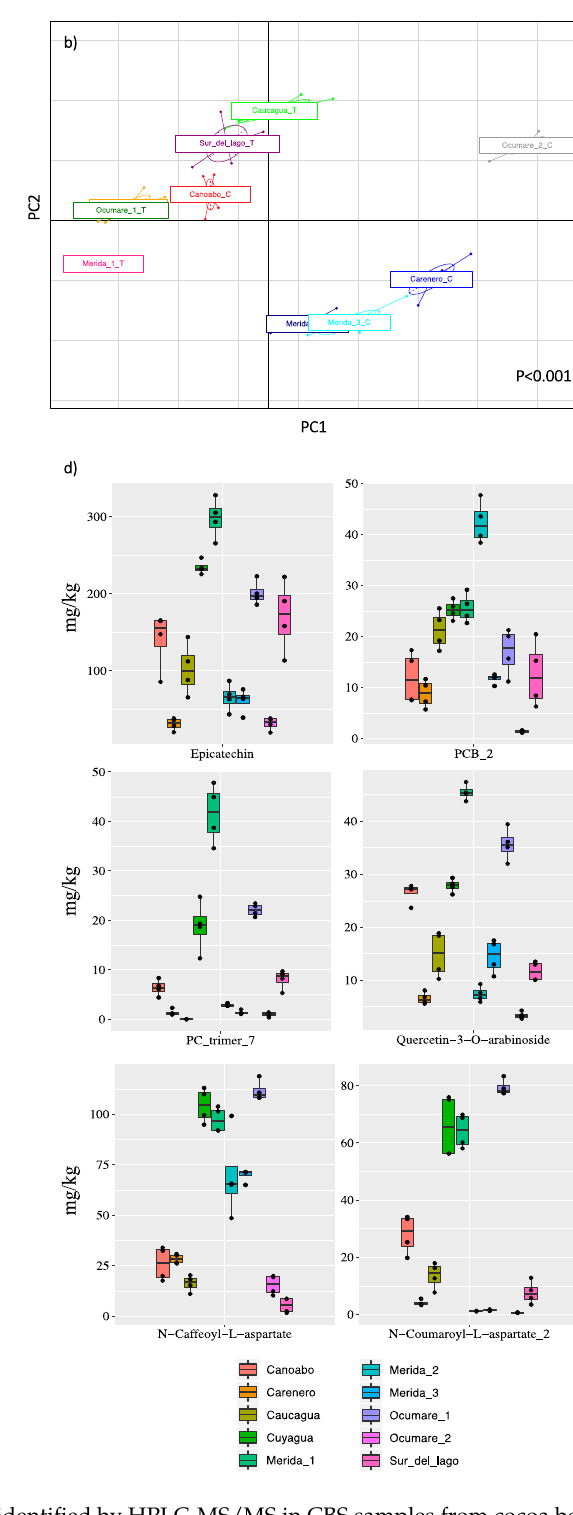
Figure 1. PCA based on the chemical compounds (mg/kg) identified by HPLC-MS/MS in CBS samples from cocoa beans growing in seven geographical areas of Venezuela according to: ( a ) cultivar and ( b ) geographical area of origin. The variance explained by the first component of PCA was 52.14%, while the second component explained 15.16%. Boxplots show the abundance of 12 chemical compounds that can be used as potential markers of CBS ( c ) cultivar and ( d ) geographical origin of cocoa beans.